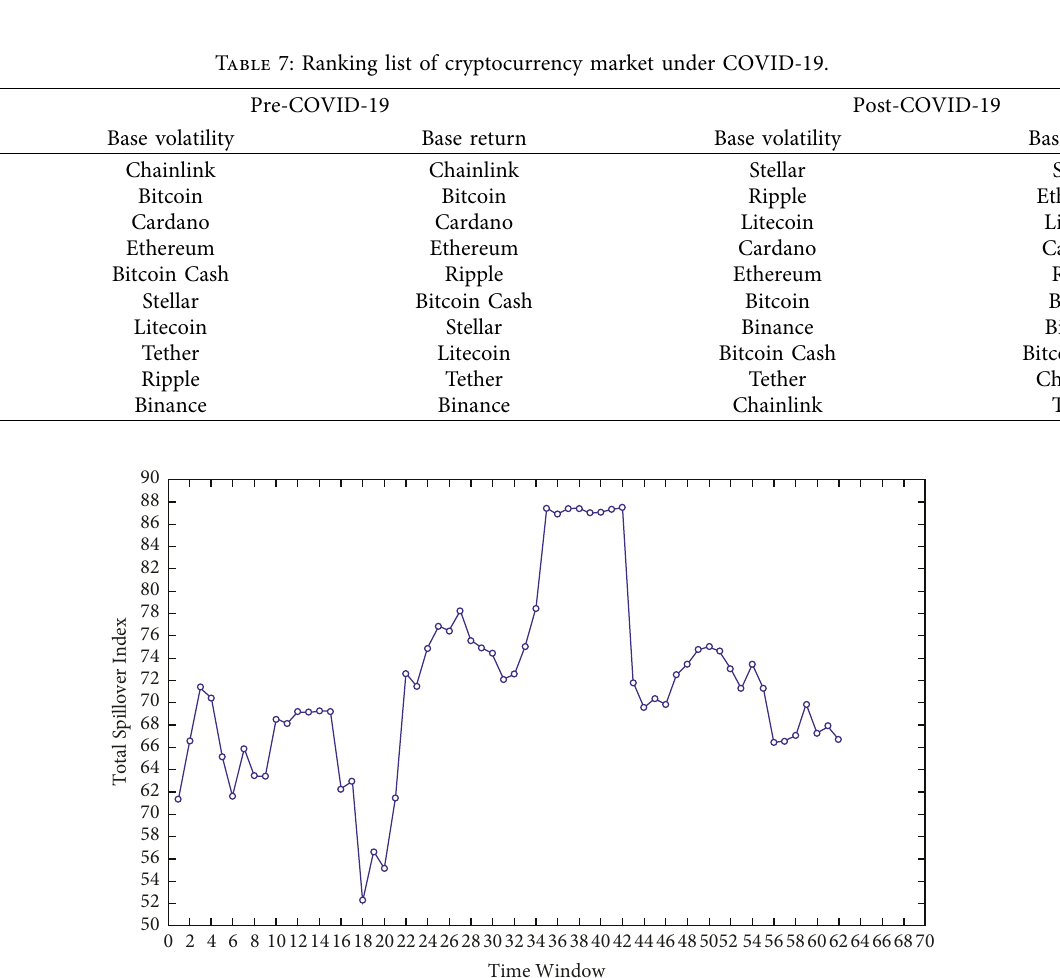
Figure 2: Total spillover index (volatility spillovers). Note: the figure shows the dynamic total connectedness based on VAR with two-day order lag length and 7-day horizon dynamic connectedness